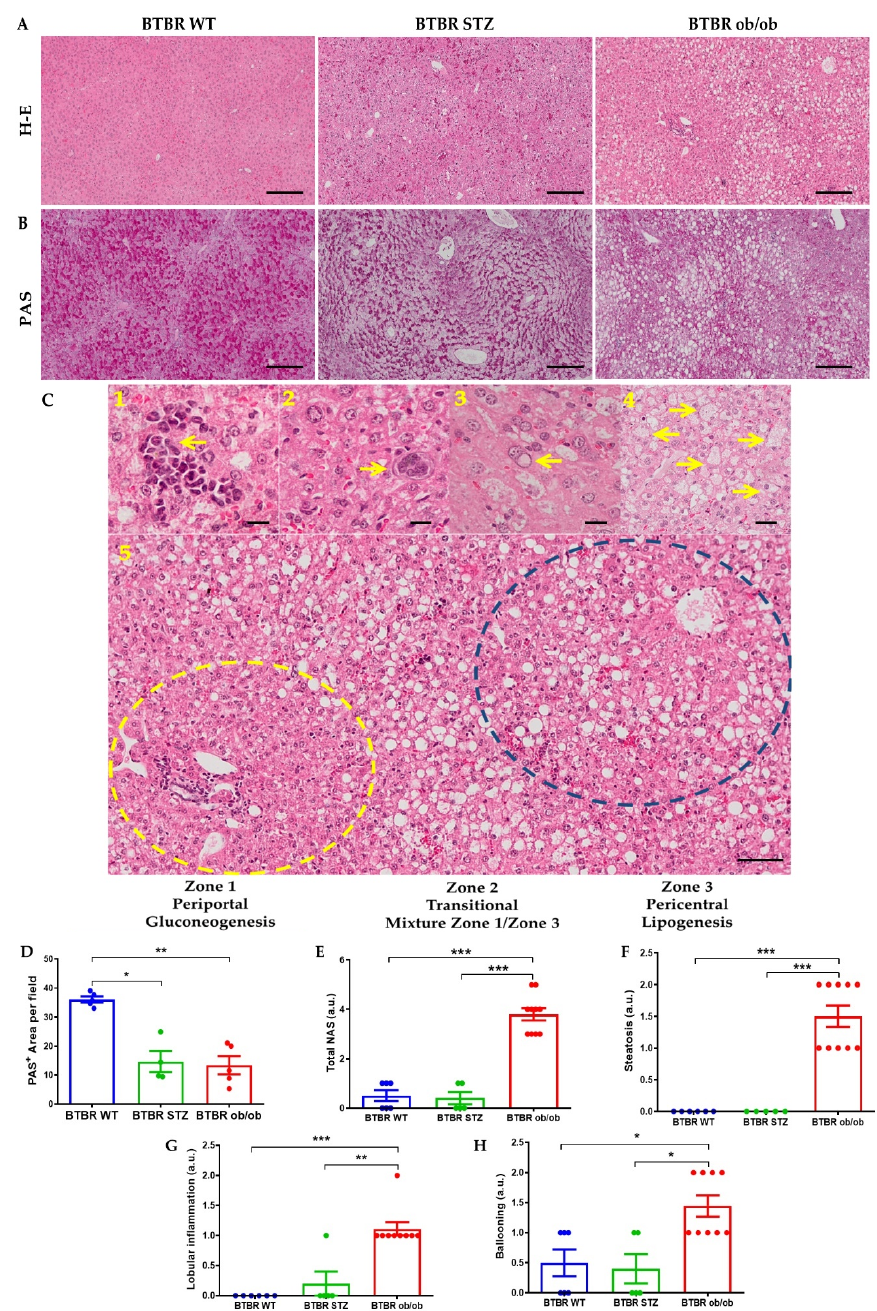
Figure 4. Liver histopathological changes at 22 weeks between BTBR WT, BTBR-STZ and BTBR ob/ob. Representative images of H-E ( A ) and PAS ( B ) staining in the 3 animal groups. ( C ) Major findings associated to MAFLD development: 1. Inflammatory clusters; 2. Isolated megakaryoblast; 3. Glycogenated nuclei; 4. Hepatocellular ballooning. 5. Steatosis distribution into 3 distinctive liver zones. ( D ) Quantification of positive Periodic Acid Schiff (PAS) staining, as glycogen liver deposition in BTBR WT, STZ and ob/ob mice. ( E ) Quantification of NAFLD activity score (total NAS) and its histopathological characteristics: ( F ) steatosis, ( G ) lobular inflammation and ( H ) hepatocytes ballooning. Data are shown as scatter dot plots and mean ± SEM of each group ( n = 5–8 mice/group); * p < 0.05, ** p < 0.01, *** p < 0.001 vs. BTBR WT or